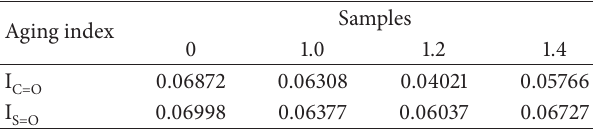
Table 3: I and I changes of base asphalt mortar after UV C=O S=O aging.